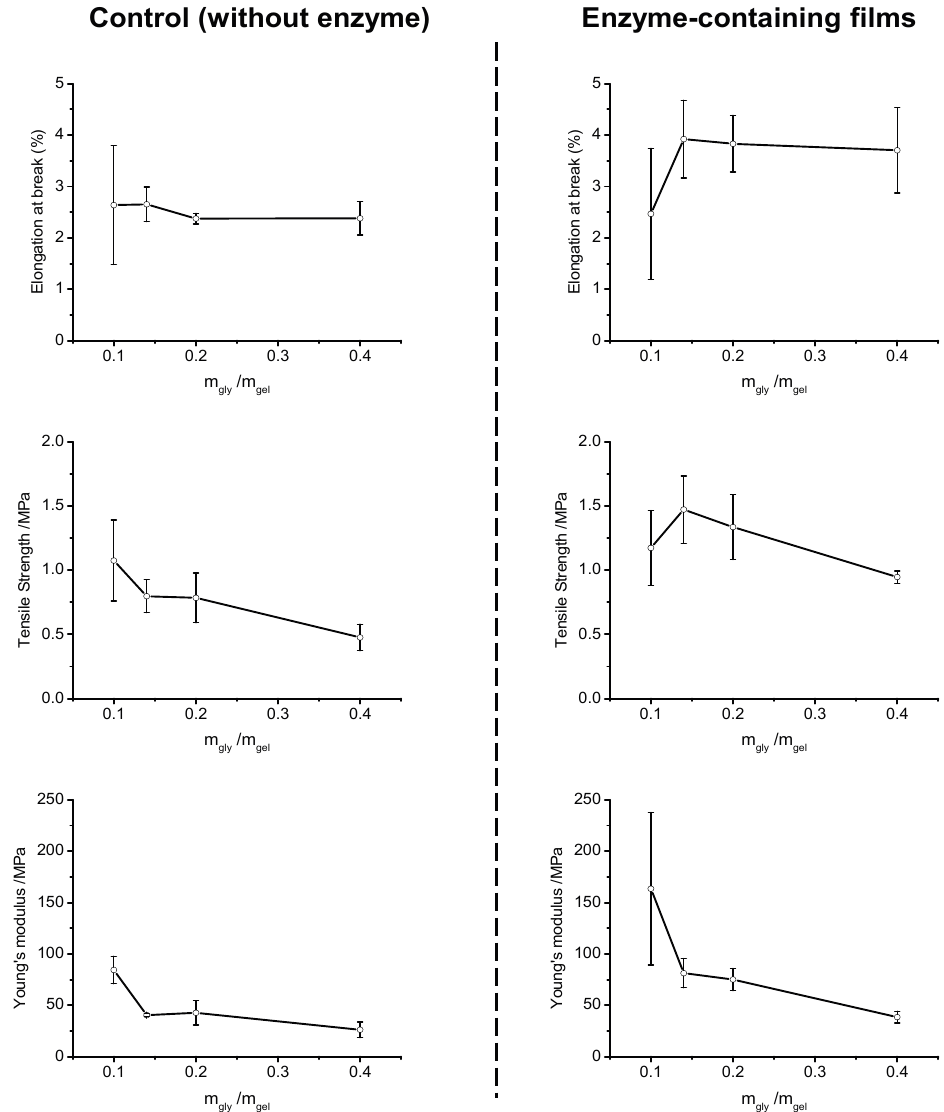
Figure 6. Mechanical properties of films as a function of glycerol concentration used as plasticizer. Left : control films, enzyme free. Right : films containing 5% β -galactosidase. Lines are shown as visual